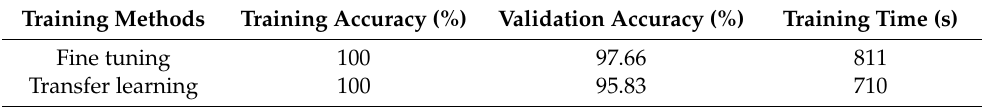
Table 4. Classification accuracy of the ship classification model via fine tuning and transfer leaning.